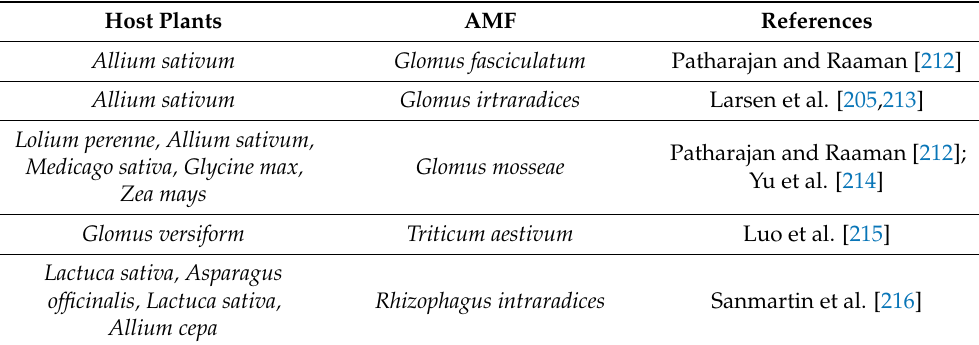
Table 5. Arbuscular mycorrhizal fungi used in Se bio-fortification.